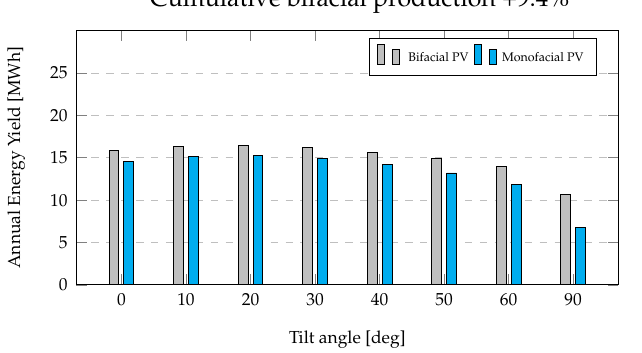
Figure 9. Investigation of the difference between bifacial and monfacial PV at varying tilt angles.